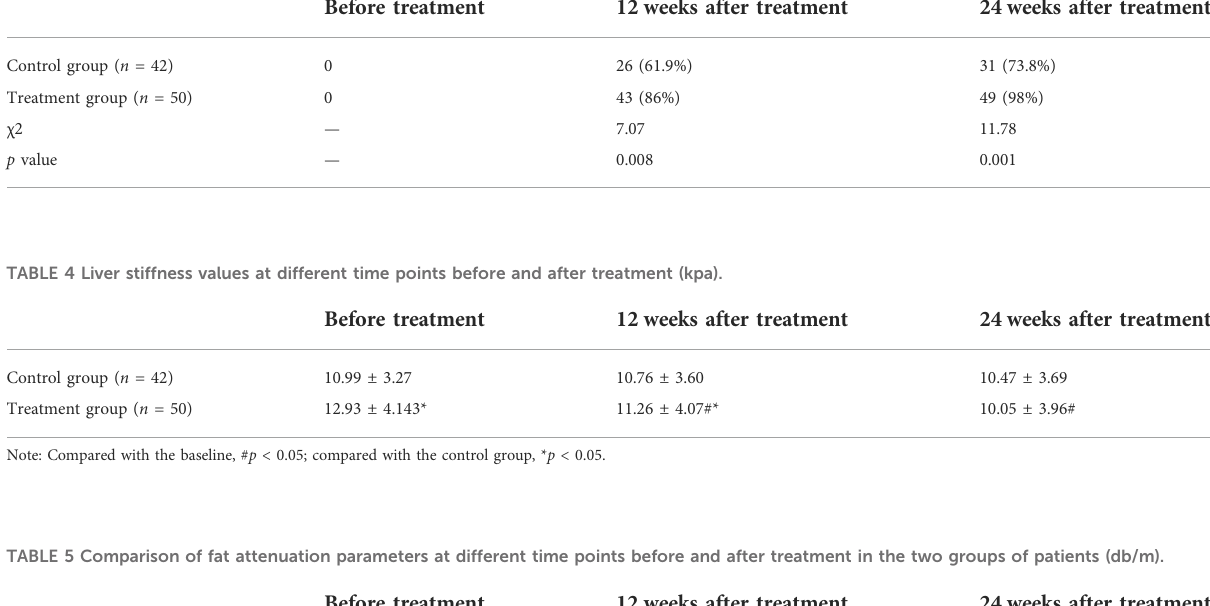
TABLE 3 Statistics on the number of patients with HBVDNA serum load < 500 IU/ml before and after treatment. Before treatment